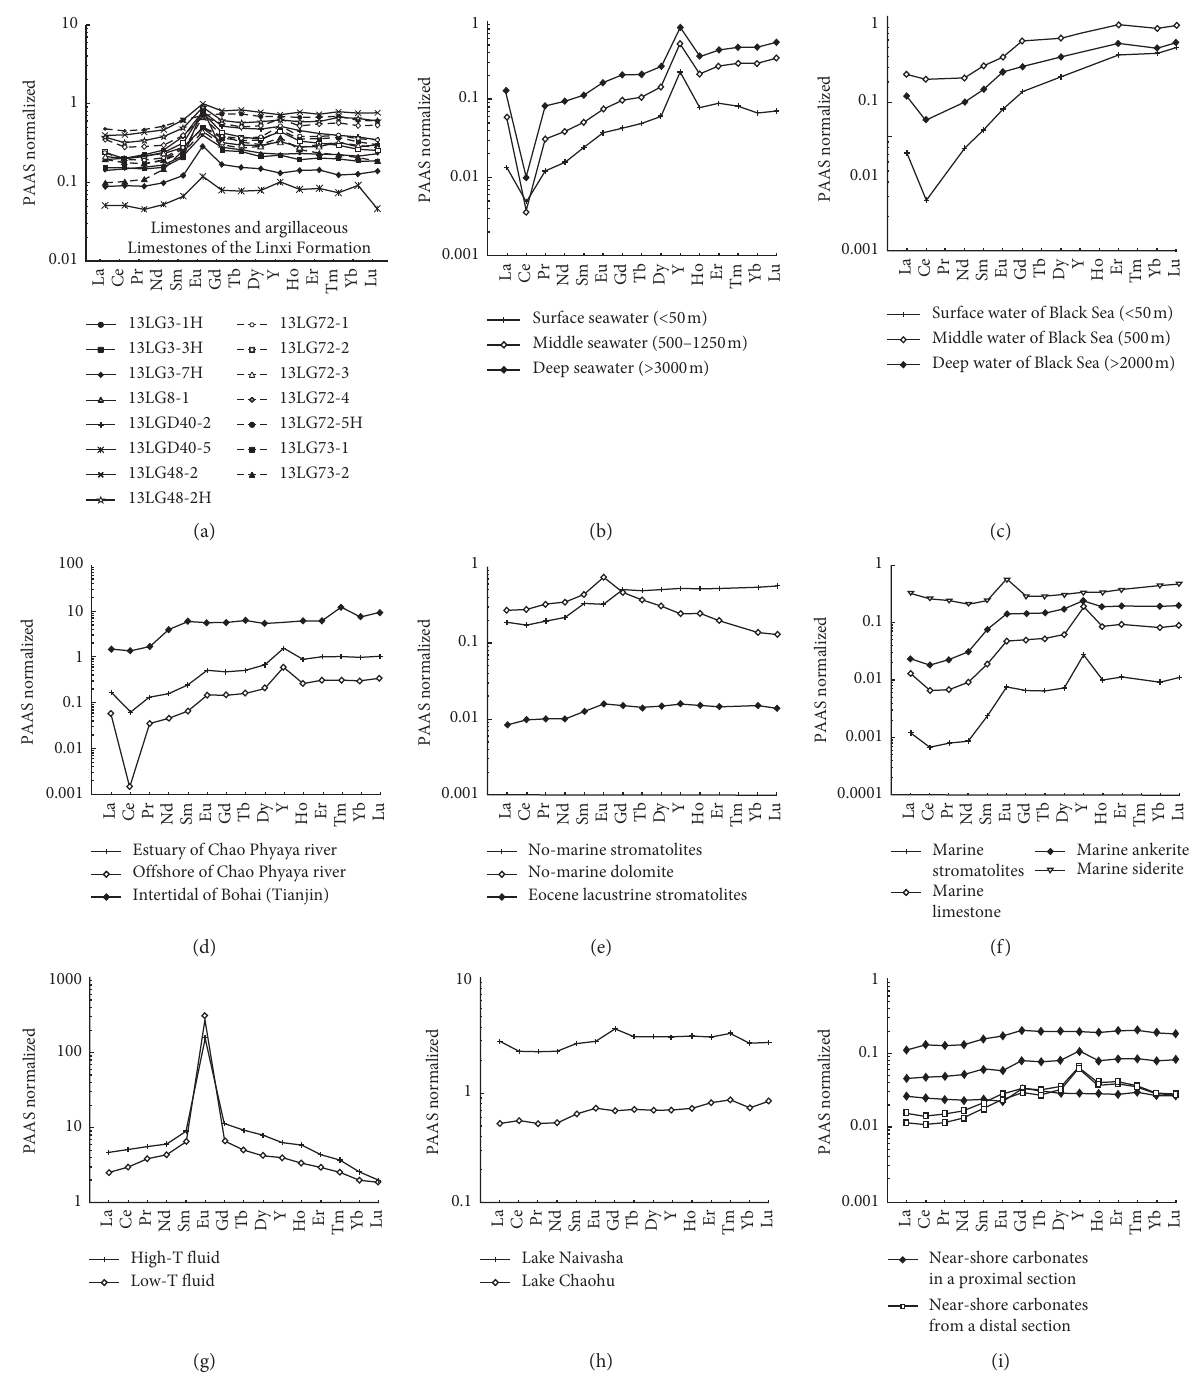
Figure 3: PAAS standardized comparison chart of the REEs of the Linxi area Guandi profile sediments and the REE of other water bodies, rocks, and minerals: the REEs of (a) limestone and mudstone in Linxi Formation, (b) seawater from southwestern Pacific [17], (c) seawater in an oxygen-poor environment of the Black Sea [18], (d) the Chao Phraya River estuarine area and distant end [19], seawater form intertidal of Bohai Sea [20], (e) nonmarine carbonate rocks [21], (f) marine carbonate rocks and marine carbonate minerals [22], (g) the high-Tand low-Tmarine hydrothermal fluids form mid-Atlantic ridge [23], (h) water from Lake Naivasha and Chaohu Lake [24, 25], and (i) near-shore carbonates of the Bloeddrif Member, lower Holgat Formation from a proximal section south of the Kuboos Pluton, and a distal section north of the Kuboos Pluton